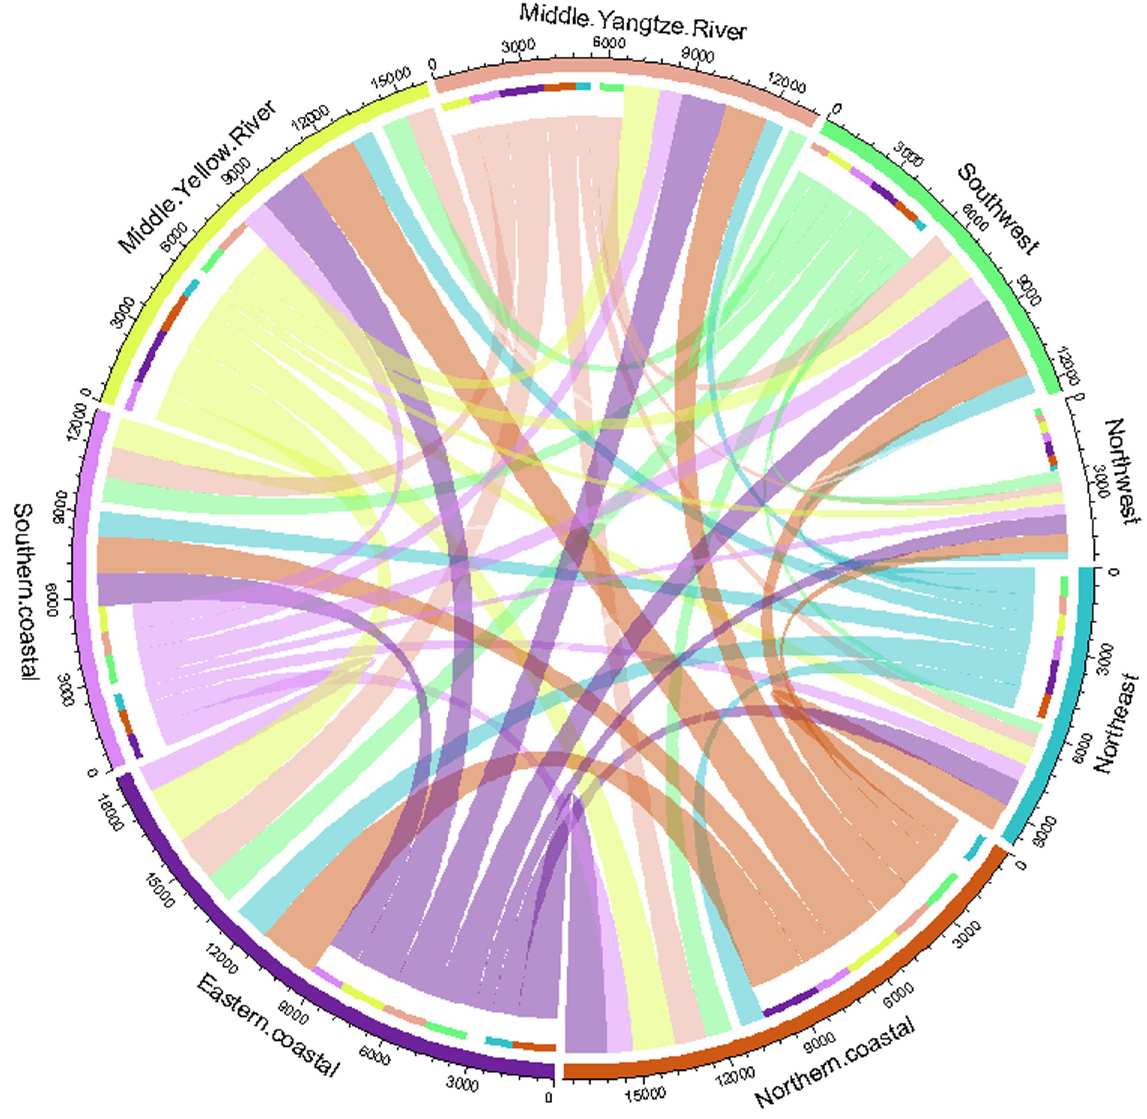
Fig 2. Value-added trade among eight regions in China in 2012 (unit: billion